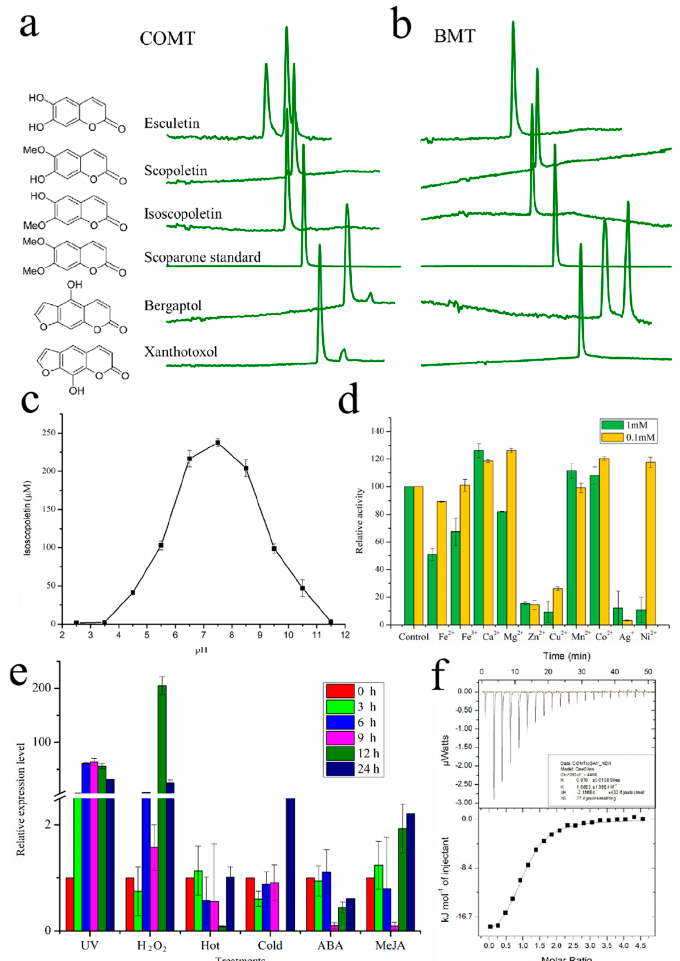
Figure 2. Functional characterization of COMT-S. HPLC analysis of the enzymatic reaction products generated by recombinant COMT-S ( a ) and PpBMT ( b ). Different hydroxylated coumarins were used as substrates and their chemical structures were marked on the left. COMT-S could accept esculetin, bergaptol, and xanthotoxl as substrates, while BMT could only catalyze bergaptol. Effect of pH ( c ) and metal ions ( d ) on the catalytic activity of recombinant COMT-S. The pH tolerance was conducted in a pH range 2.5 to 11.5. The effects of different metal ions (Fe 2+ , Fe 3+ , Ca 2+ , Mg 2+ , Zn 2+ , Cu 2+ , Mn 2+ , Co 2+ , Ag + , and Ni 2+ ) in different concentrations (both in 1 and 0.1 mM) on COMT-S were displayed in relative activity. The activity of COMT-S without ions treatment was set as 100%. ( e ) Expression profiles of COMT-S. Different treatments (UV, H 2 O 2 , Hot, Cold, ABA, MeJA) were listed in the X axis and their relative expression level were shown as fold changes to the expression level of COMT-S without treatment (0 h). Different colors indicate different treatment time. All the data represents means ± SD of three replicates. ( f ) ITC (Isothermal Titration Calorimetry) analysis of COMT-S.